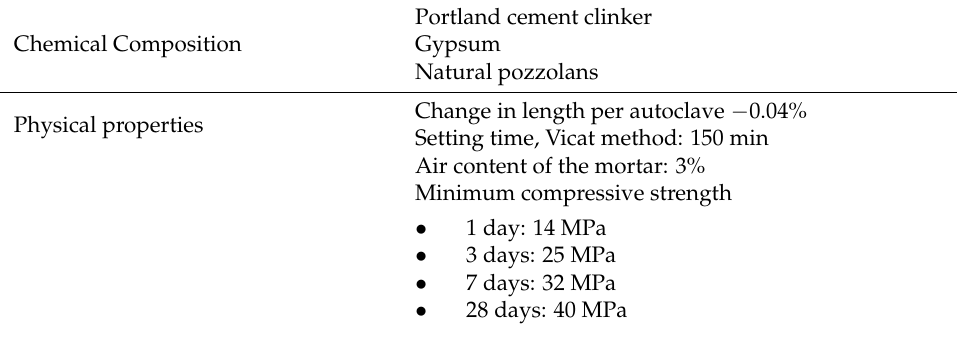
Table 1. Chemical composition and physical properties of the cement HE given by